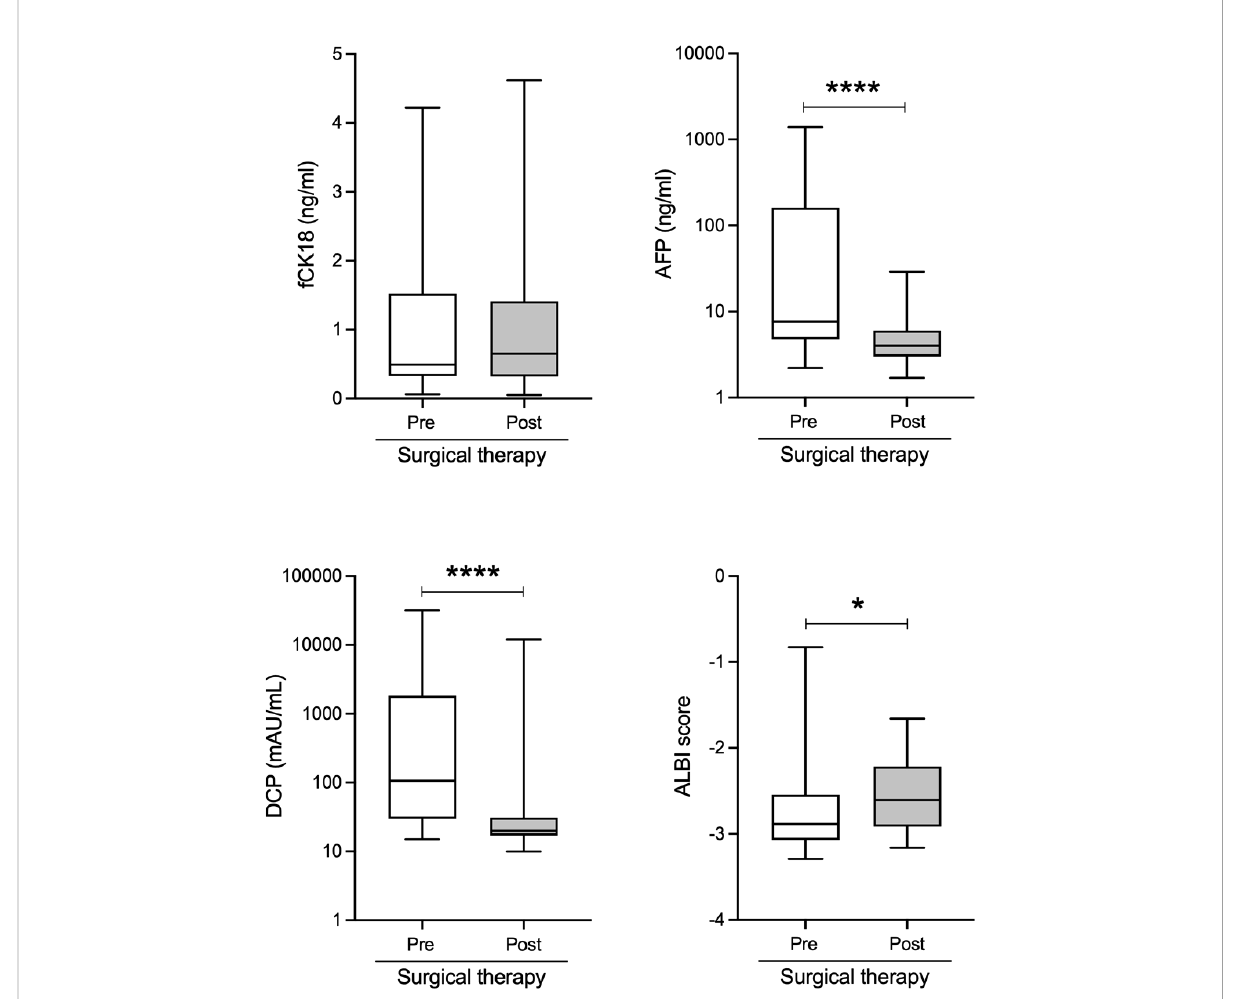
FIGURE 5 Serum fCK18 levels are not changed by the surgical therapy in HCC patients. Changes of serum fCK18, AFP and DCP levels, as well as ALBI score in HCC patients who received surgical resection. fCK18, fragmented cytokeratin 18; AFP, alpha-fetoprotein; DCP, des-gamma-carboxy prothrombin; ALBI, albumin-bilirubin. * p<0.05, ****